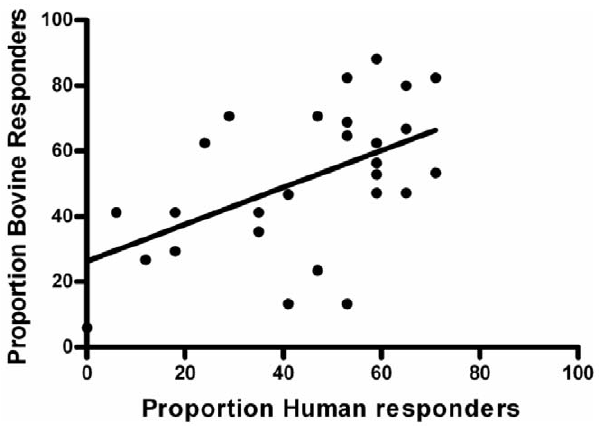
Figure 2. Comparison of proportion responders in human and bovine hosts with active TB. Responses to 28 PE/PPE peptide pools were assessed in both cattle and humans with active TB, by Bovigam or ELISPOT assays. Individual cattle samples were scored as positive if D OD 450 values were $ 0.1, and human samples were scored as positive if $ 20 SFC were counted per 10 6 PBMC. Linear regression analysis produced the line shown. A Pearson correlation test revealed a statistically significant correlation between the proportion human responders and the proportion bovine responders; r(26) =0.539, 2- tailed p value